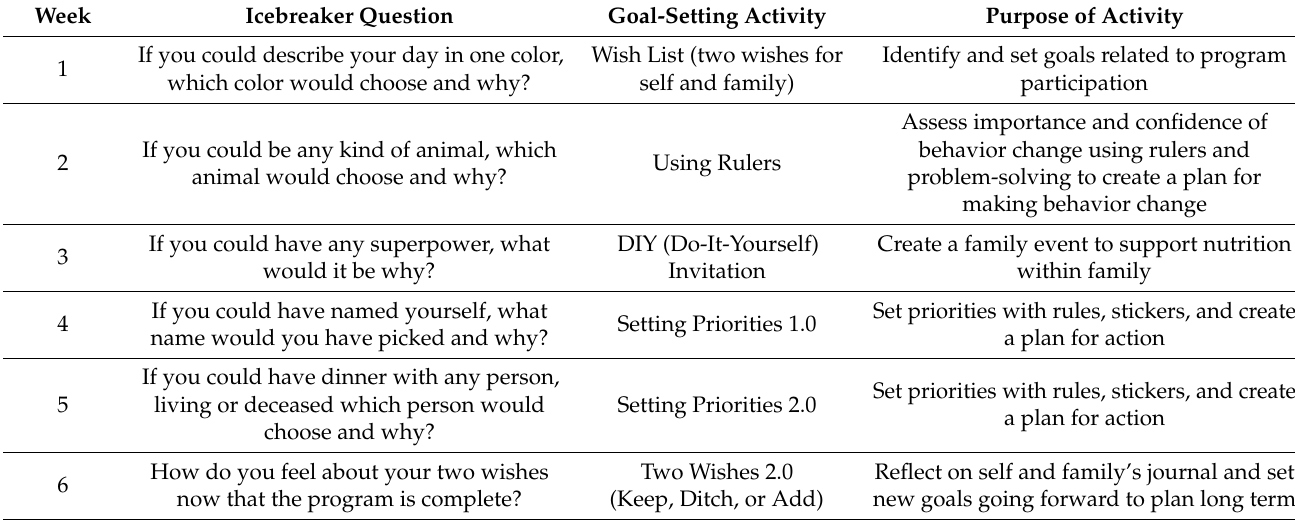
Table 5. Icebreaker questions and goal-setting activities for the eating together lessons.